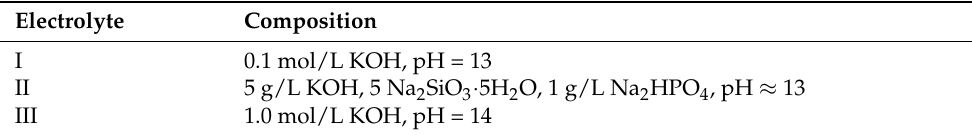
Table 2. Composition of the electrolytes used for the exposition experiments.